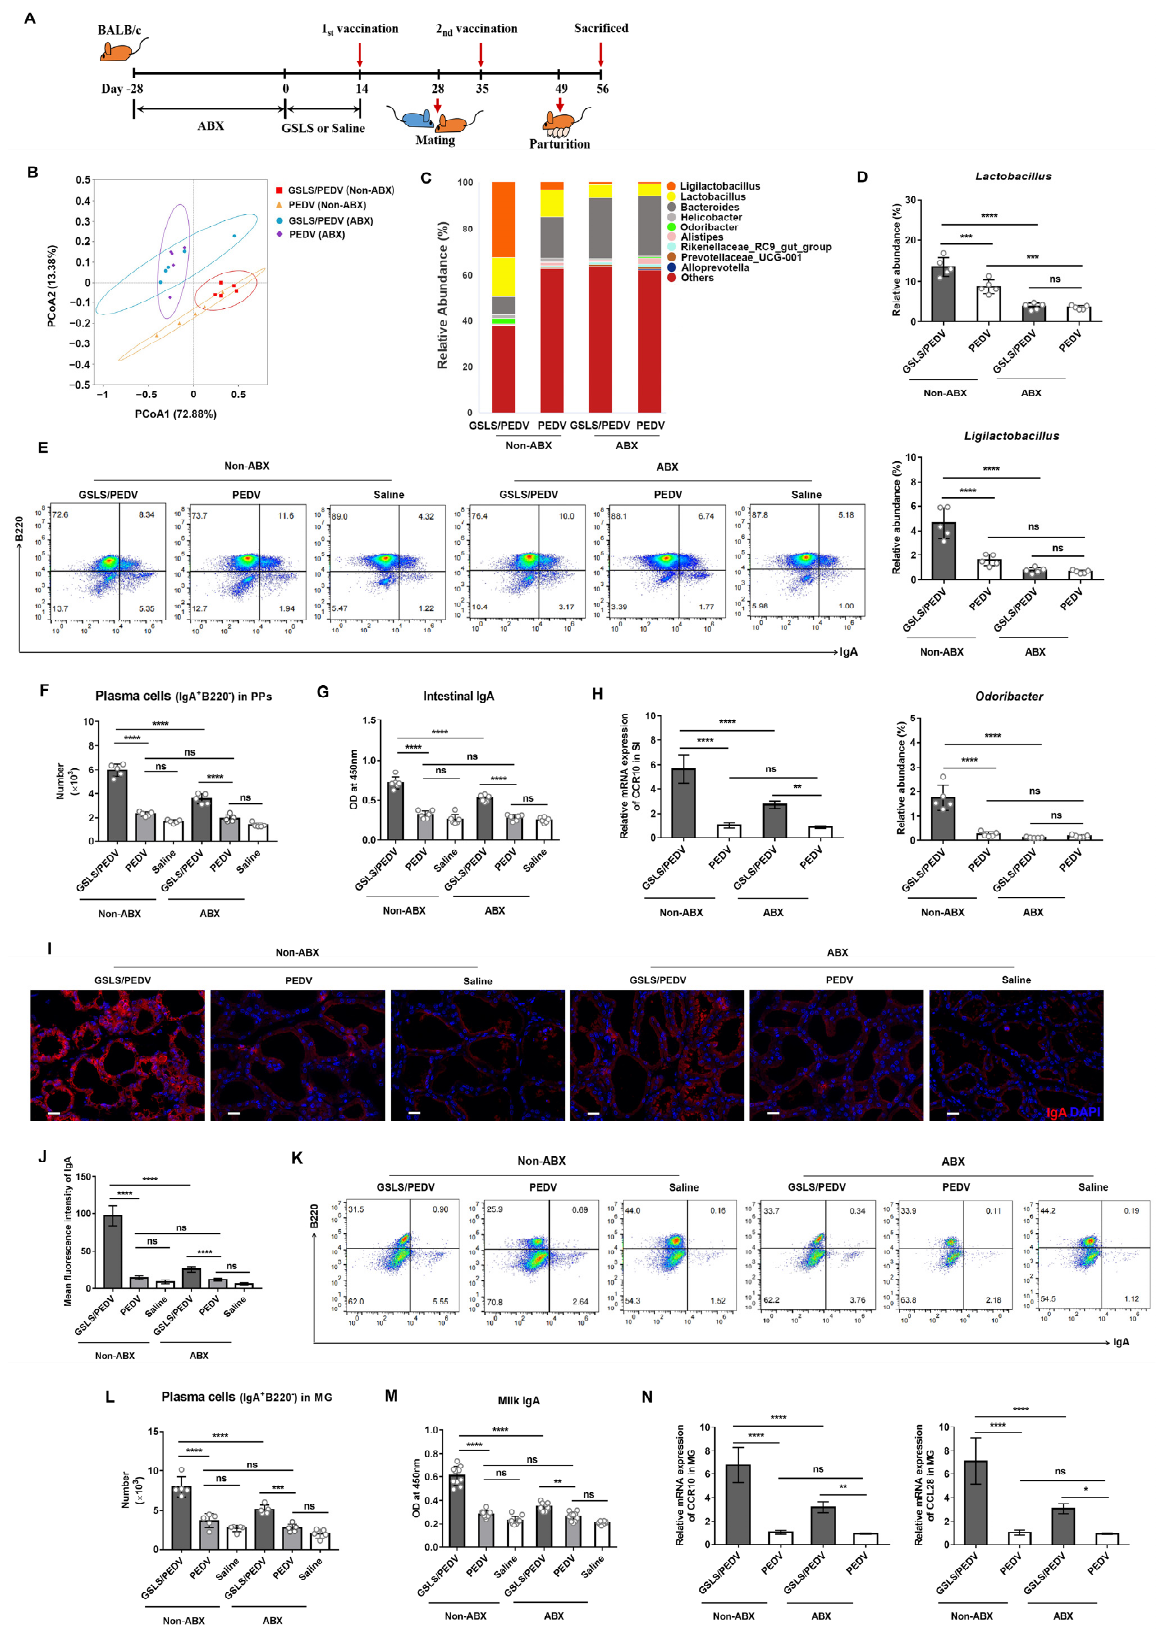
Figure 3. The intestinal microflora affects the GSLS-enhanced maternal IgA antibody response. After disruption of the original intestinal flora using ABX for 4 weeks, female BALB/c mice ( n =